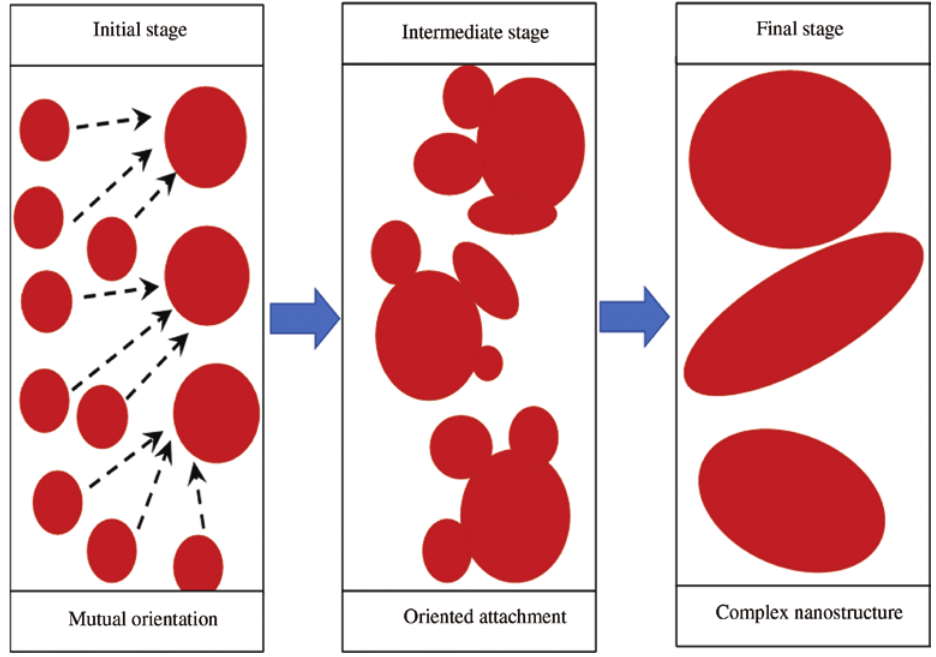
Figure 6: Nanocrystal orientation-based growth mechanism due to Oswald’s ripening of poly-dispersed